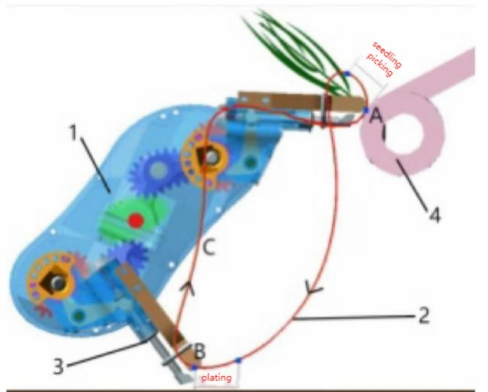
Figure 3. Seedling trajectory diagram. 1, gearbox; 2, transplanting trajectory; 3, transplanting arm; 4, hole